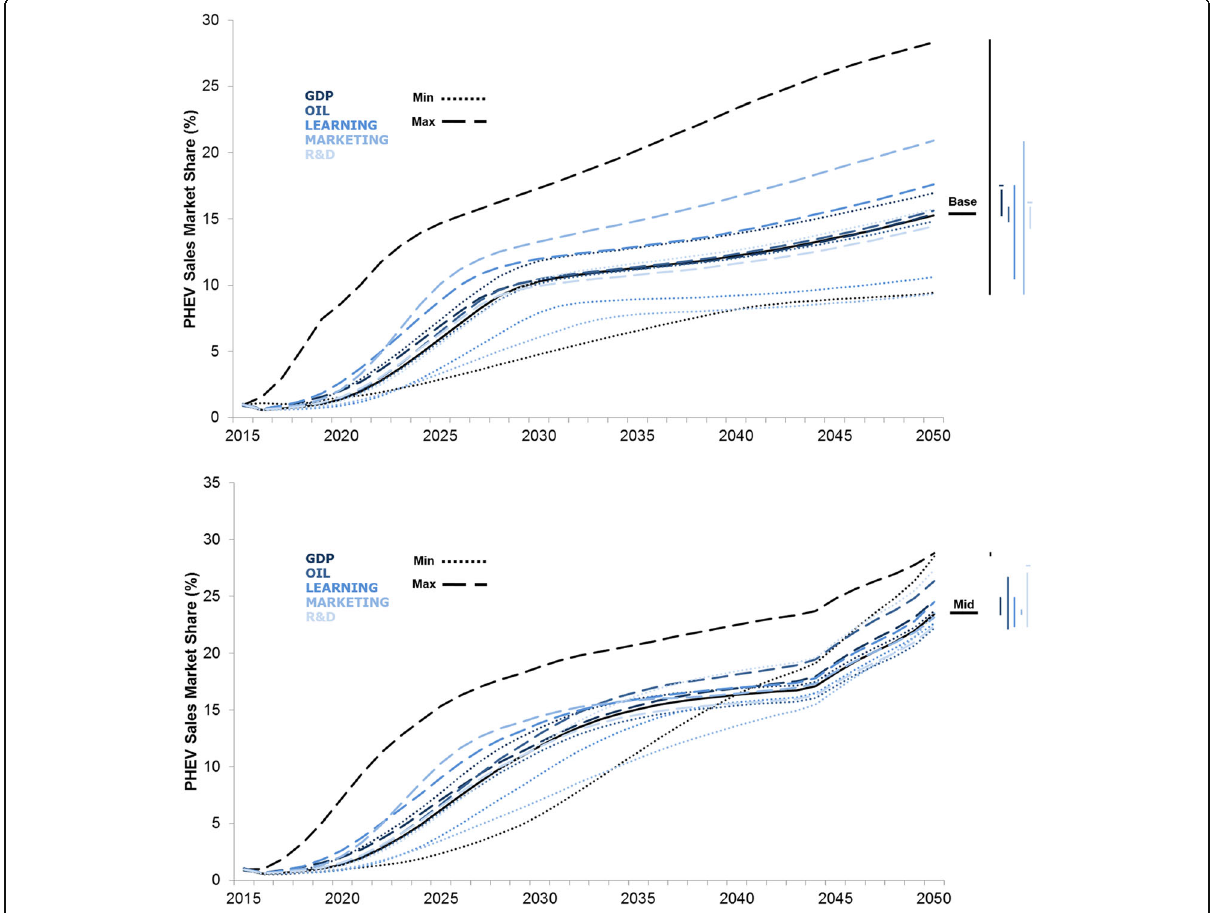
Fig. 4 EU28 PHEV sales share to 2050 under Base (top) and Mid (bottom) fleet emission targets, showing range between Min and Max